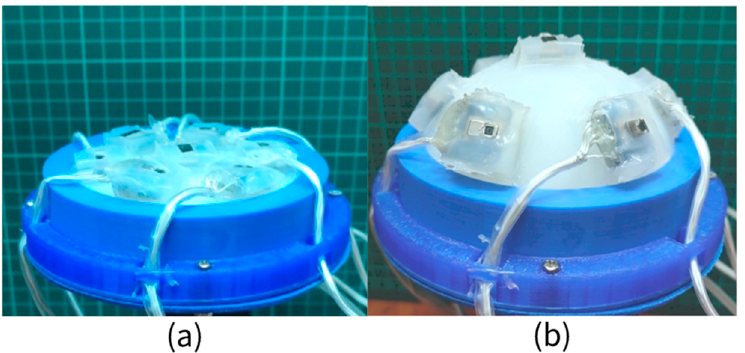
Figure 14. VSICE model. ( a ) The VSICE in the initial state is in the plane compound eye mode. ( b ) The shape of the VSICE in the inflated state is a curved compound eye